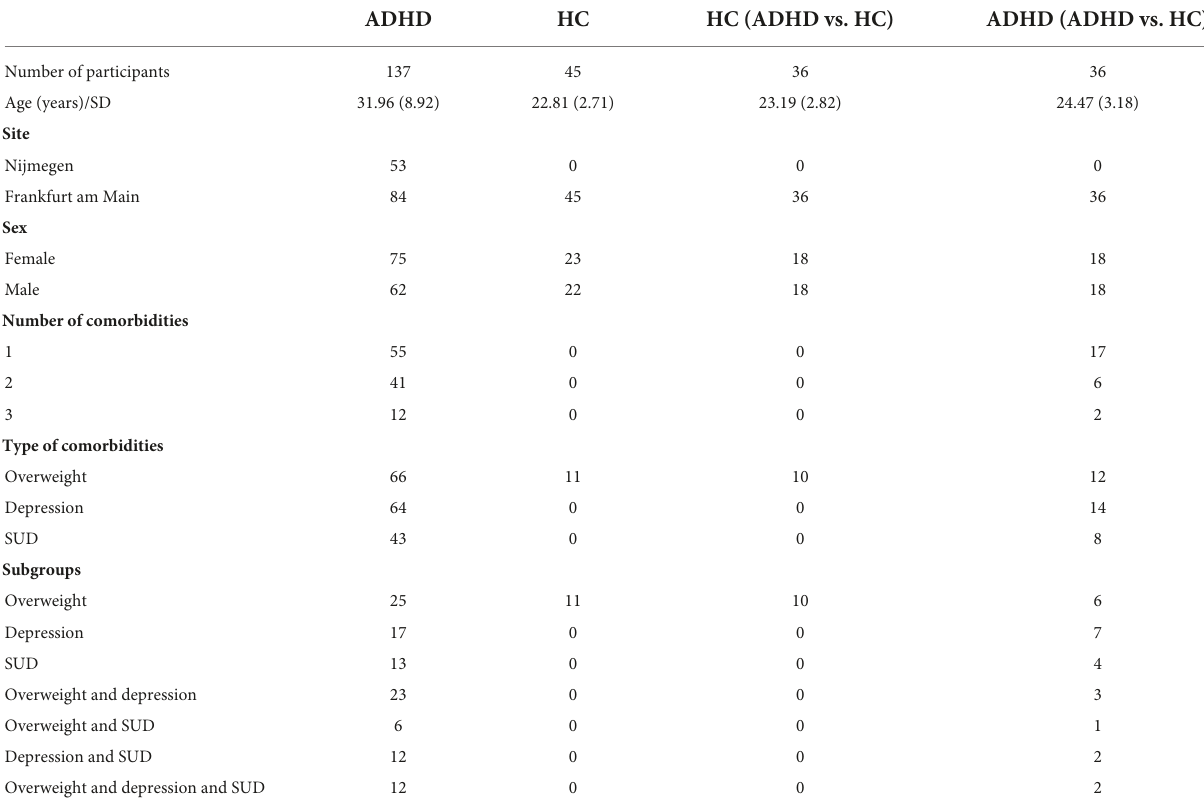
TABLE 1 Demographic